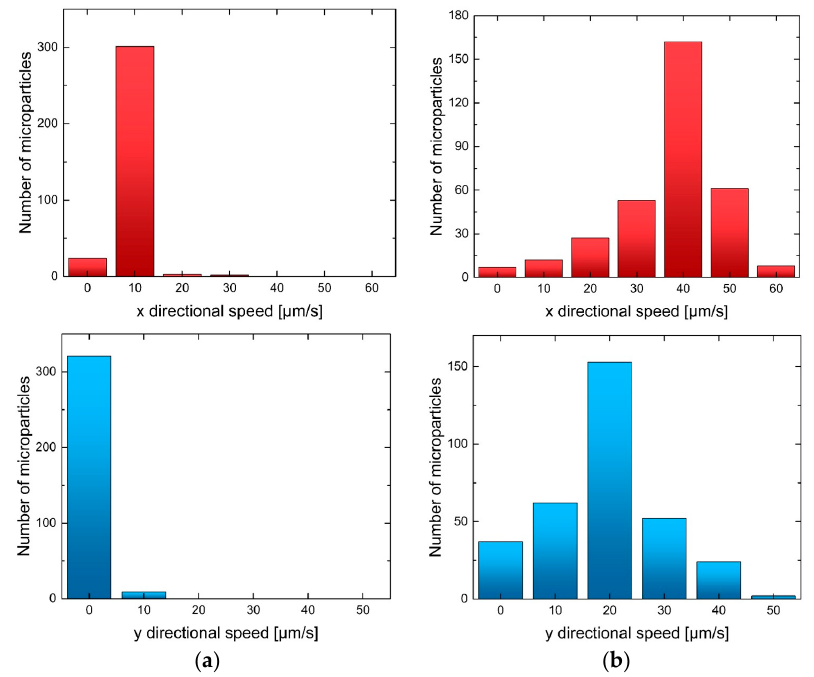
Figure 5. Speed distribution in ( a ) a non-vortex region and ( b ) a vortex region (see Figure 1).